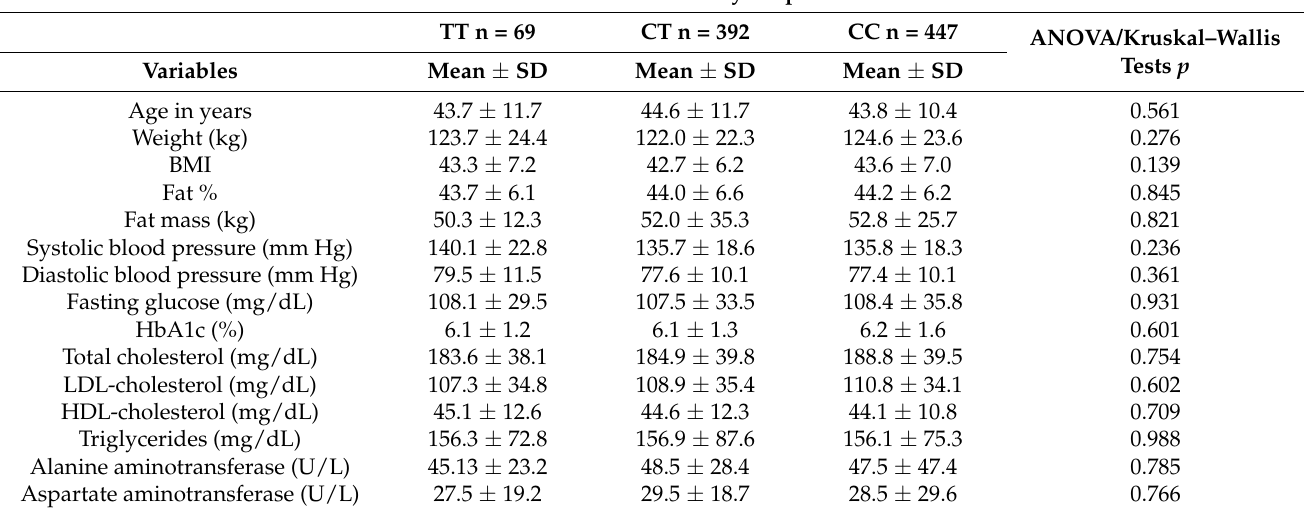
Table 4. The characteristics of patients with BMI ≥ 35 kg/m 2 according to MTHFR C677T